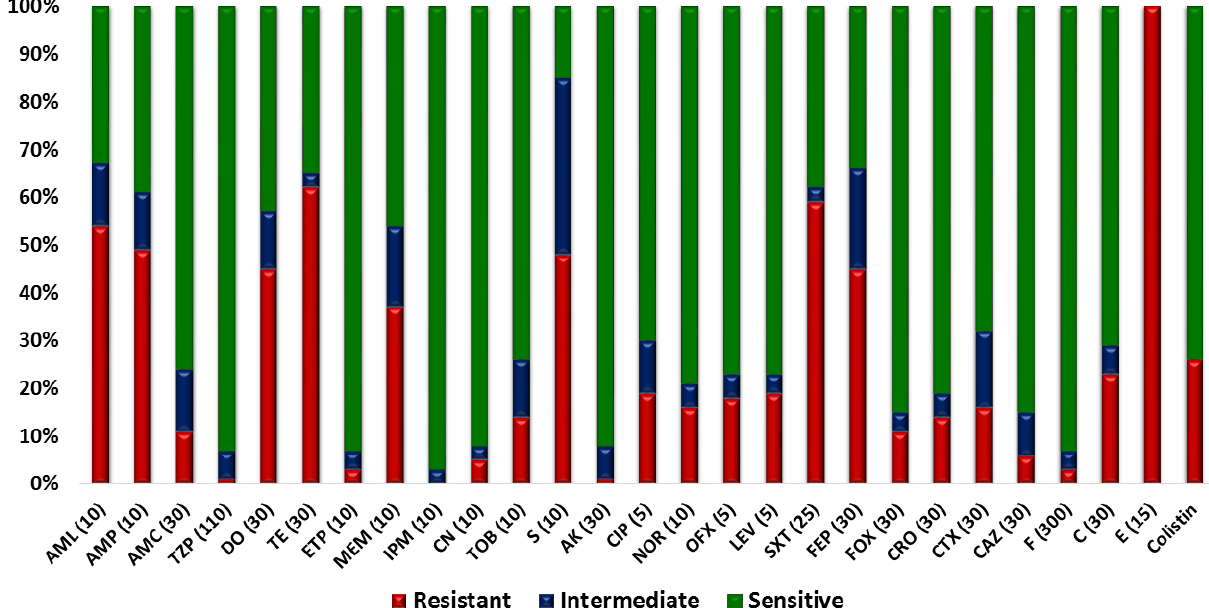
Figure 3. In vitro antibiotic-susceptibility pattern of isolates; a stacked-bar chart showing the per- centage resistance and sensitivity of bovine fecal E. coli isolates towards tested antibiotics. The antibiotics used in AST profiling include (1) amoxicillin (AML, 10 µ g), (2) Ampicillin (AMP, 10 µ g), (3) amoxicillin-clavulanate (AMC, 20/10 µ g), (4) doxycycline (DO, 30 µ g), (5) tetracycline doxycycline (TE, 30 µ g), (6) piperacillin-tazobactam (TZP, 100/10 µ g), (7) eratapenem (ETP, 10 µ g), (8) meropenem (MEM, 10 µ g), (9) imipenem (IPM, 10 µ g), (10) gentamicin (CN, 10 µ g), (11) tobramycin (TOB, 10 µ g), (12) streptomycin (S, 10 µ g), (13) amikacin (AK, 30 µ g), (14) ciprofloxacin (CIP, 5 µ g), (15) norfloxacin (NOR, 10 µ g), (16) ofloxacin (OFX, 5 µ g), (17) levofloxacin (LEV, 5 µ g), (18) trimethoprim- sulfamethoxazole (SXT, 25 µ g), (19) cefepime (FEP, 30 µ g), (20) cefoxitin (FOX, 30 µ g), (21) ceftriaxone (CRO, 30 µ g), (22) cefotaxime (CTX, 30 µ g), (23) ceftazidime (CAZ, 30 µ g), (24) nitrofurantoin (F, 300 µ g), (25) chloramphenicol (C, 30 µ g), (26) erythromycin (E, 15 µ g), and (27) colistin